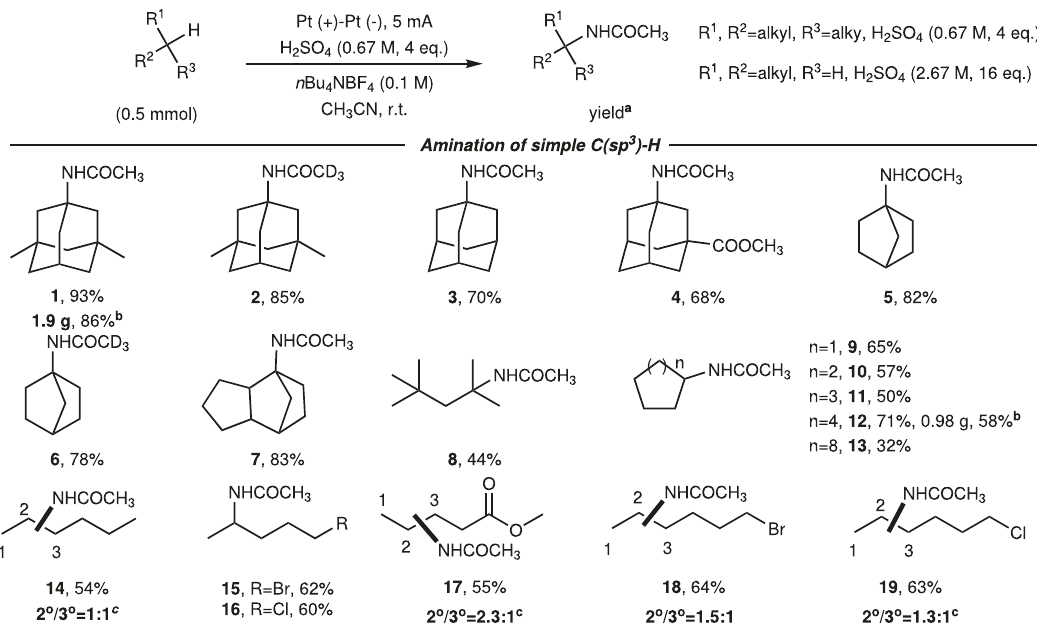
Fig. 2 Reaction scope of alkyl substrates. a Isolated yield; b Electrolysis performed on 10 mmol scale; c Regio isomeric ratios were determined by 1 H